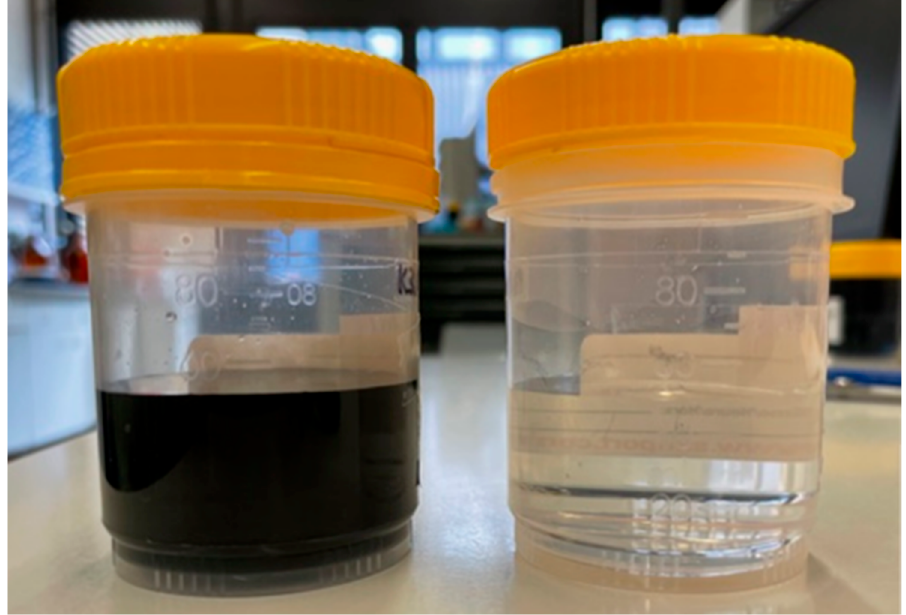
Figure 4. Photo of RO concentrate K3.1 (left) and permeate P3.1 (right). The concentrates show a dark blue color.